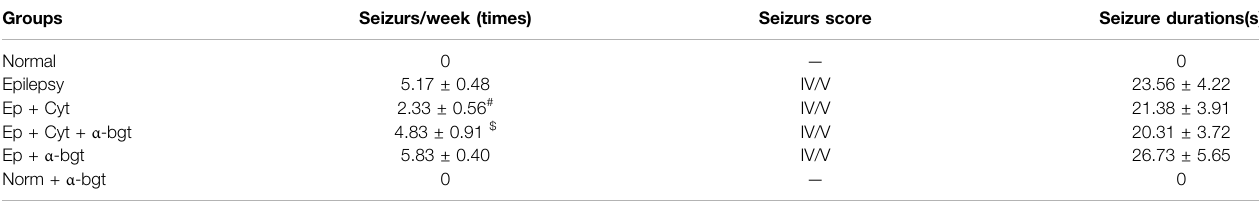
TABLE 1 | Cytisine reduces the frequency of SRS in epileptic rats. Groups